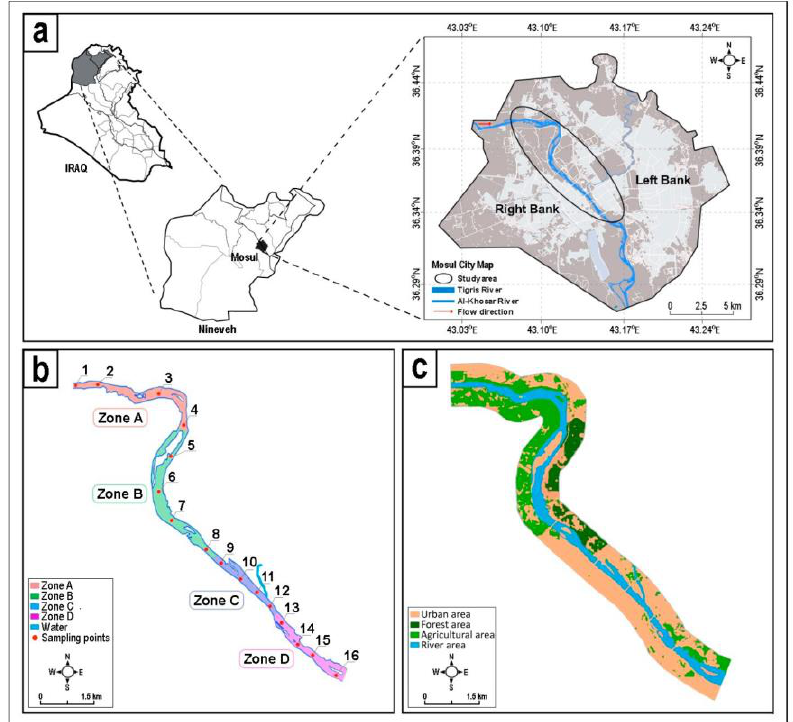
Figure 2. ( a ) Map showing the study area in Iraq; ( b ) Map showing the sampling points in red dots. The red area is Zone A; green area is Zone B; blue area is Zone C, and purple area is Zone D. ( c ) Map showing the land use in the Tigris River in the city of Mosul.